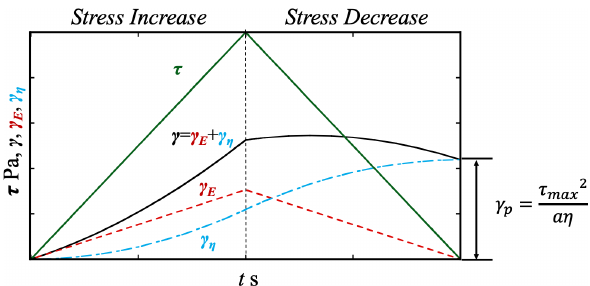
Figure 2: Strain response in the hysteresis loop test. The elastic strain is perfectly recovered, and the viscous strain is retained as